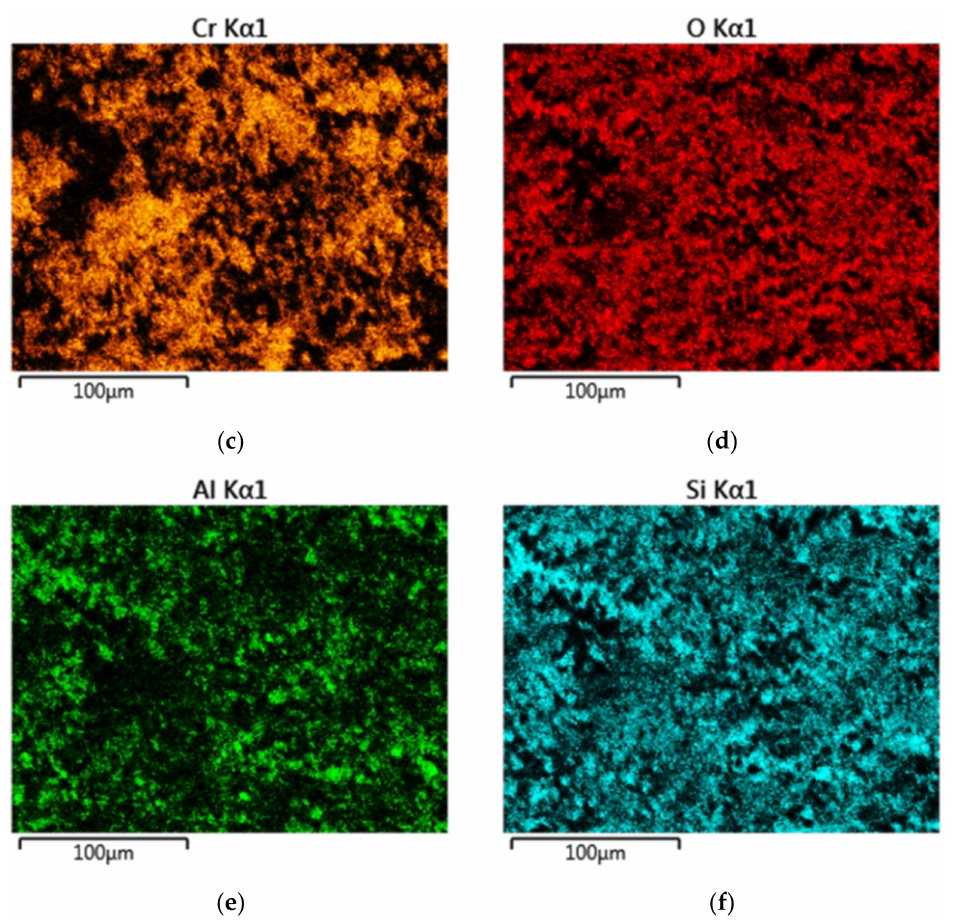
Figure 1. Microscopic image with the spatial distribution of elements in the fracture of S45 specimen (600 kPa/50 µ m); ( a ) topography view; ( b ) surface distribution of nickel; ( c ) surface distribution of chromium; ( d ) surface distribution of oxygen; ( e ) surface distribution of aluminum; ( f ) surface distribution of